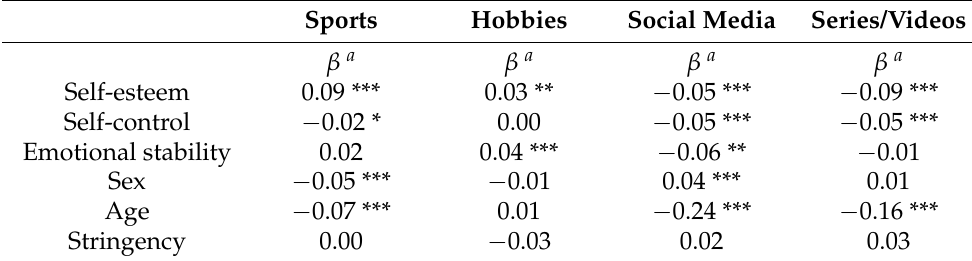
Table 4. Total effects of psychological factors on leisure